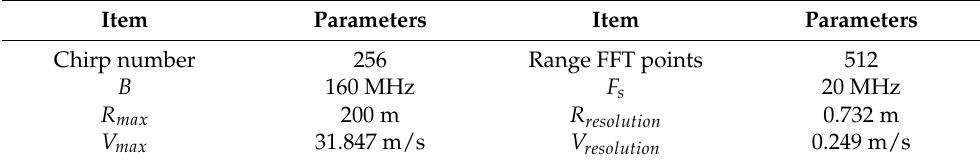
Figure 6. ( a ) Radar system. ( b ) Data collection scenario. Table 2. Radar system